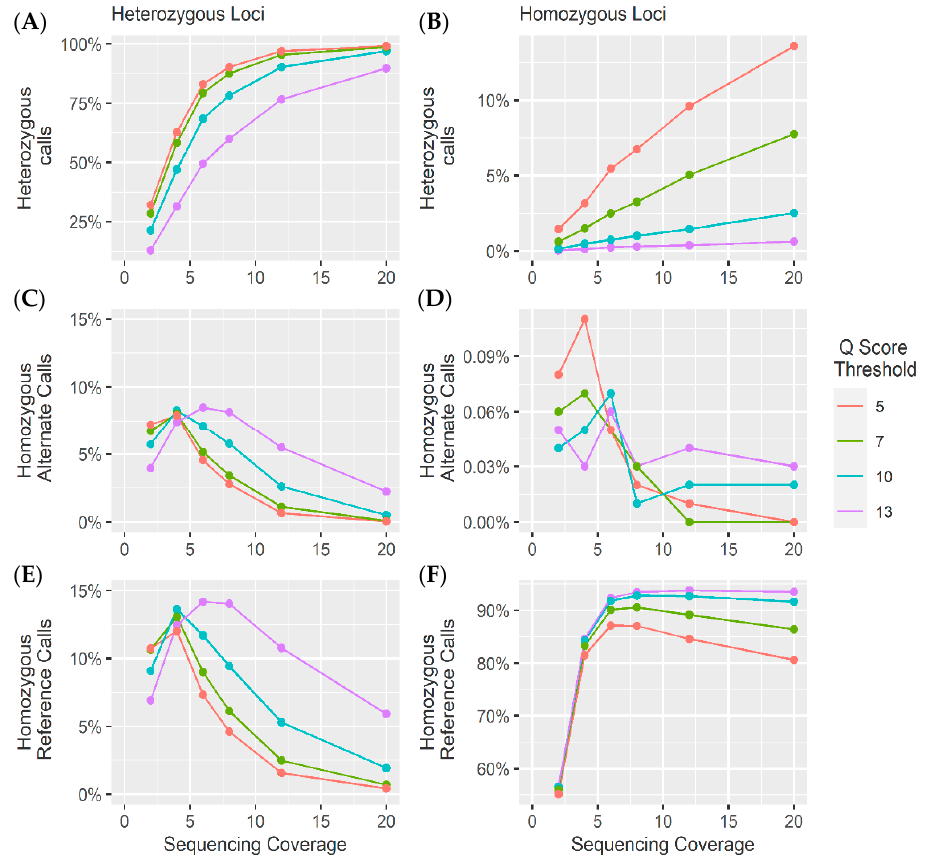
Figure 5. Genotype calling results from the 10,000 heterozygous loci (left) and 10,000 homozygous sites (right) at di ff erent sequencing coverages. ( A ) The percentage of SNPs correctly identified (heterozygous). ( B ) The percentage of false heterozygous alternate calls. ( C ) The percentage of false homozygous reference calls. ( D ) The percentage of false homozygous alternate calls. ( E ) The percentage of false homozygous reference calls. ( F ) The percentage of accurate homozygous reference calls.